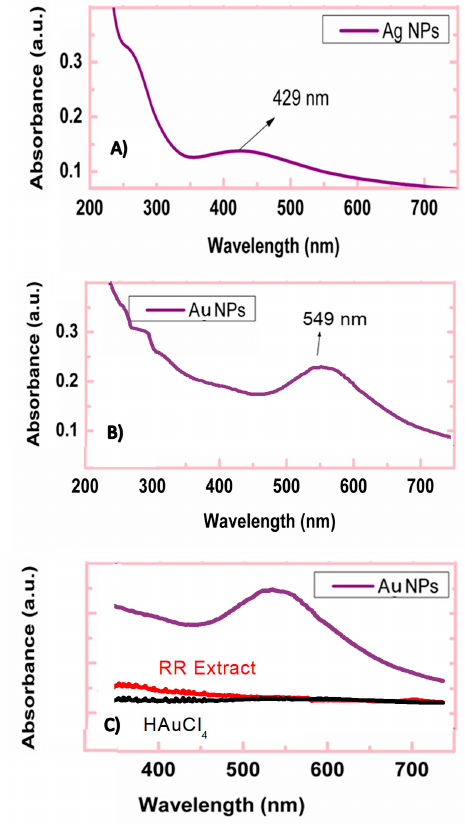
Figure 1. UV-Vis spectra recorded in the reaction solution for the synthesis of ( A ) AgNPs and ( B ) AuNPs. Plasmonic peaks assigned to metal nanoparticles are indicated by arrows. ( C ) UV-Vis spectra of the Rumex roseus (RR) plant extract and Au metal precursor are also shown .